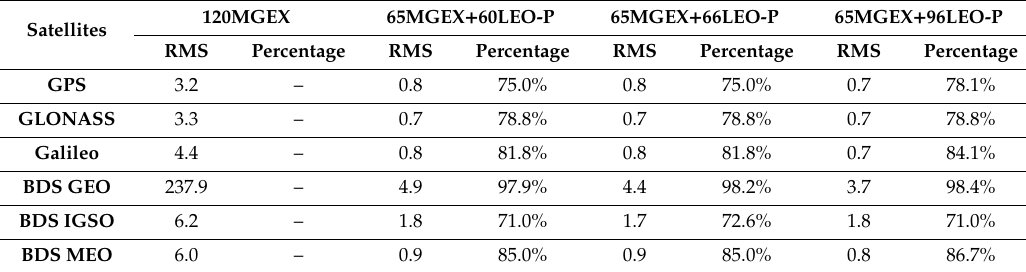
Table 4. Average 3D RMS of GNSS orbit differences and improvement percentages with respect to the ground-based POD using MGEX data (Unit: cm).